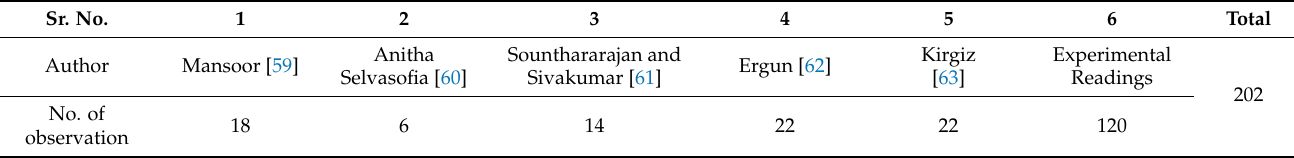
Table 6. Detail of dataset.